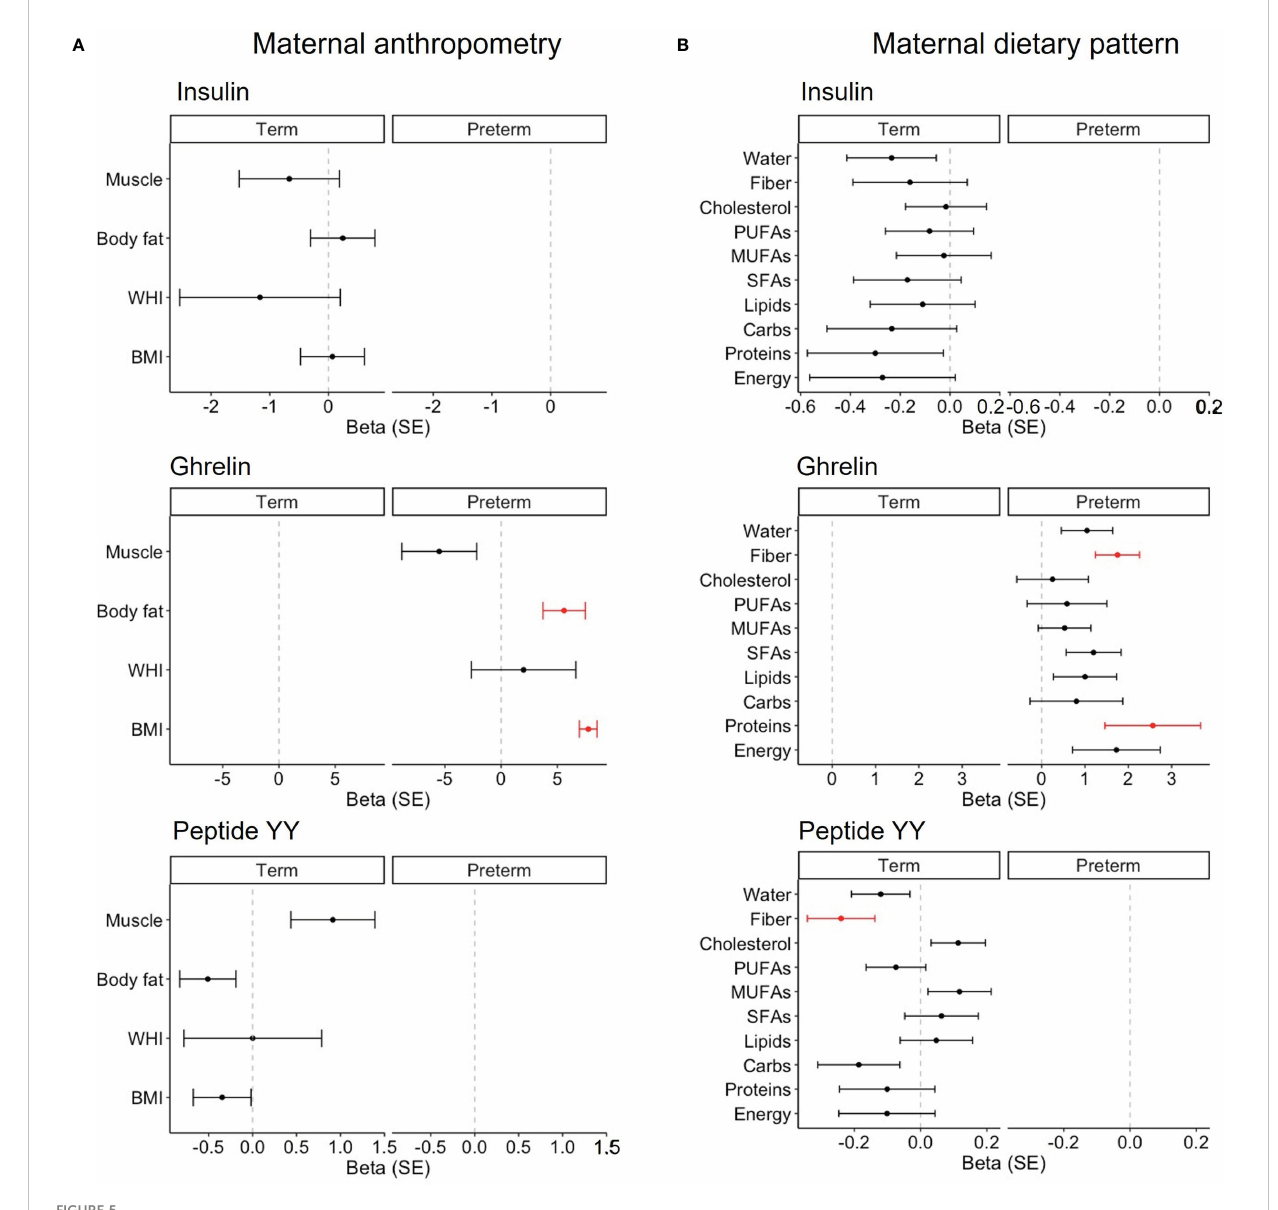
FIGURE 5 Linear mixed models on the association between maternal anthropometry (A) and the maternal dietary pattern (B) on BM hormones that in fl uenced neonatal growth in each cohort. Women by day were included as the random effect, and maternal variables were normalized by logarithmic transformation. Data show beta and SE. Red lines mean signi fi cant association (P < 0.05), and non-signi fi cant associations are represented in black. BMI, body mass index; WHI, waist-to-hip index; SFAs, saturated fatty acids; MUFAs, monounsaturated fatty acids; PUFAs, polyunsaturated fatty